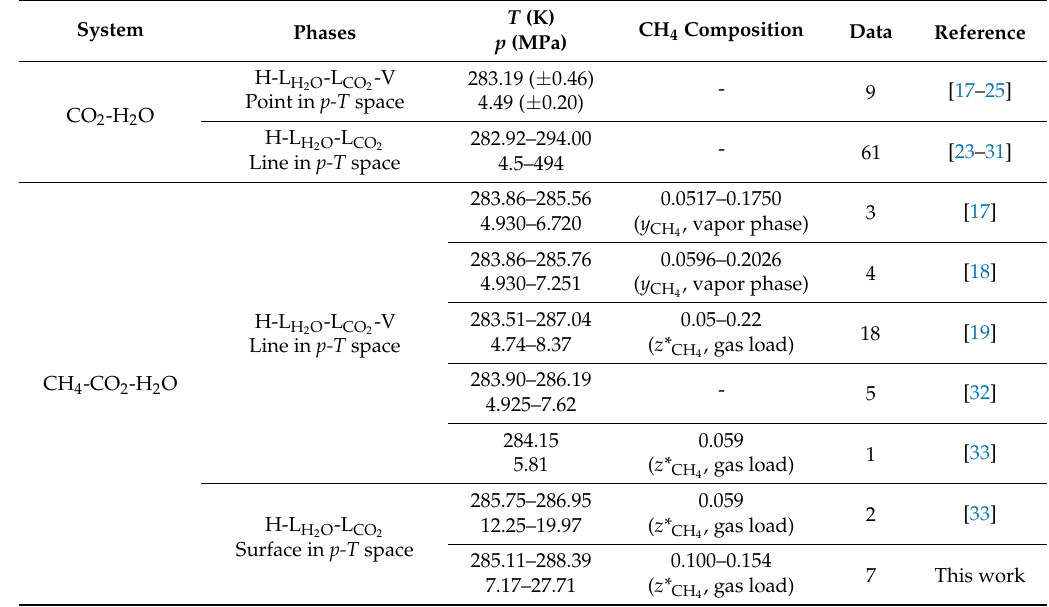
Table 2. Available experimental data for the CO 2 -H 2 O binary and CH 4 -CO 2 -H 2 O ternary mixtures involving a CO 2 -rich liquid